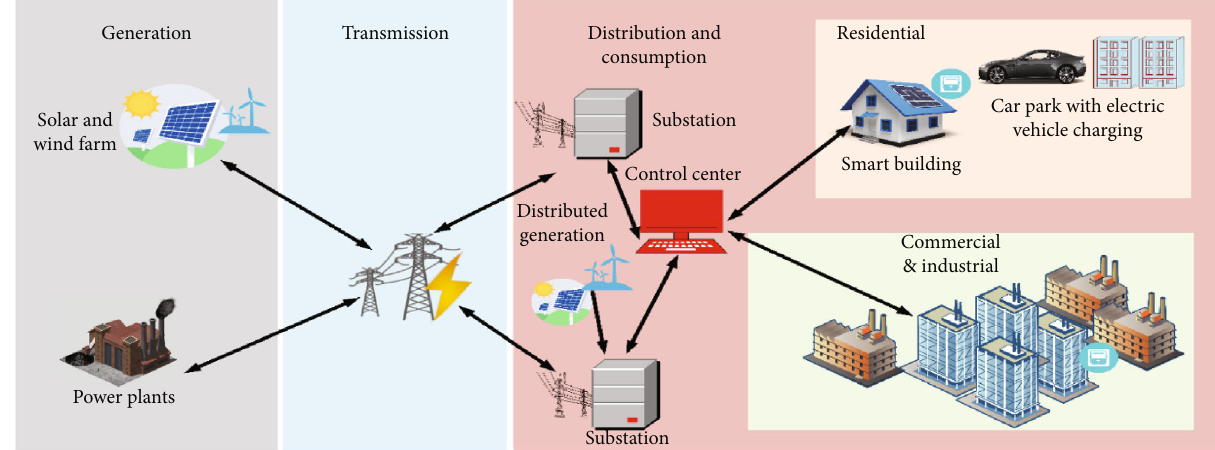
Figure 1: Model structure